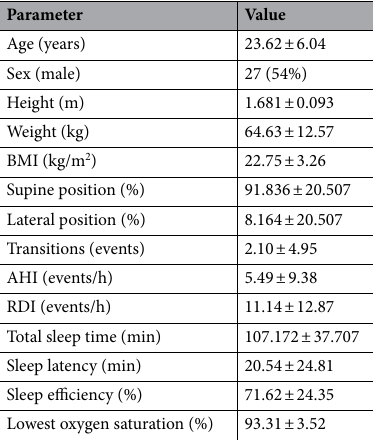
Table 1. Demographic data and sleep parameters of the study population. Data are shown as the mean ± standard deviation or N (%). AHI apnea–hypopnea index, BMI body mass index, RDI respiratory disturbance